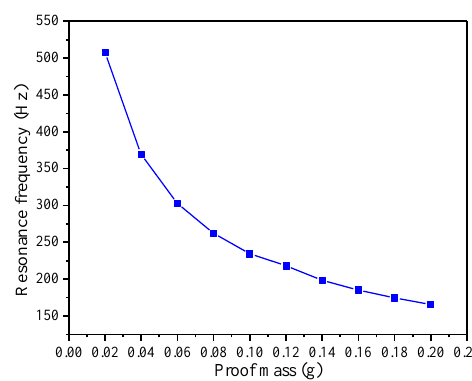
Figure 6. The resonance frequency versus the proof